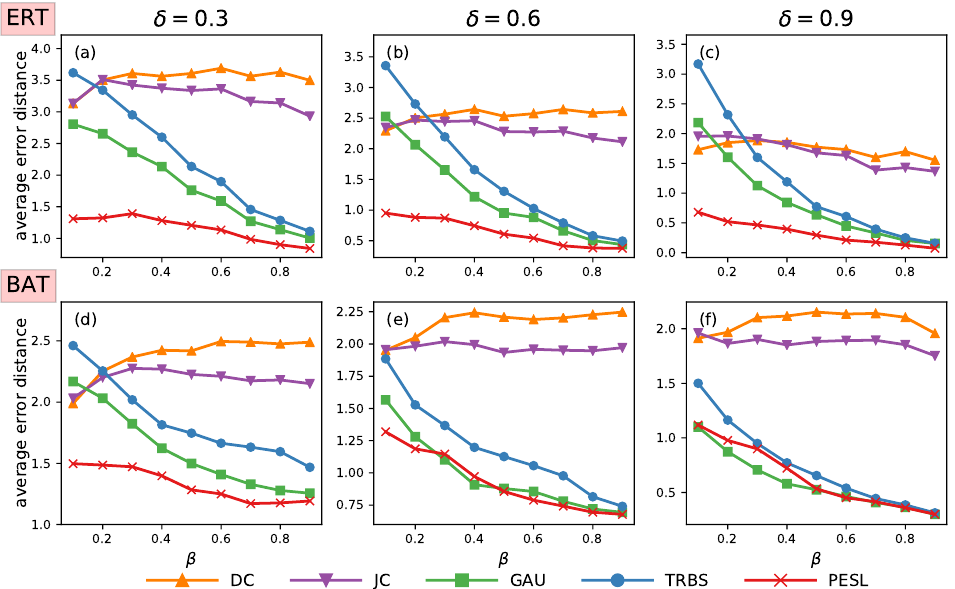
Figure 2. The relationship between epidemic source localization accuracy and infection probability in tree networks. ( a – c ) represent the relationship between average error distance and infection probability in ERT under the different reporting probability of nodes δ = 0.3,0.6,0.9 respectively. ( d – f ) represent the same results in BAT. In the figure, the abscissa represents the infection probability β of SIR model, the ordinate denotes the distance between the real source and the source found by different source localization algorithms. The recovery probability used in the simulation is γ = 0.1 and the number of observers is K = 10, which are same in Figure 3.